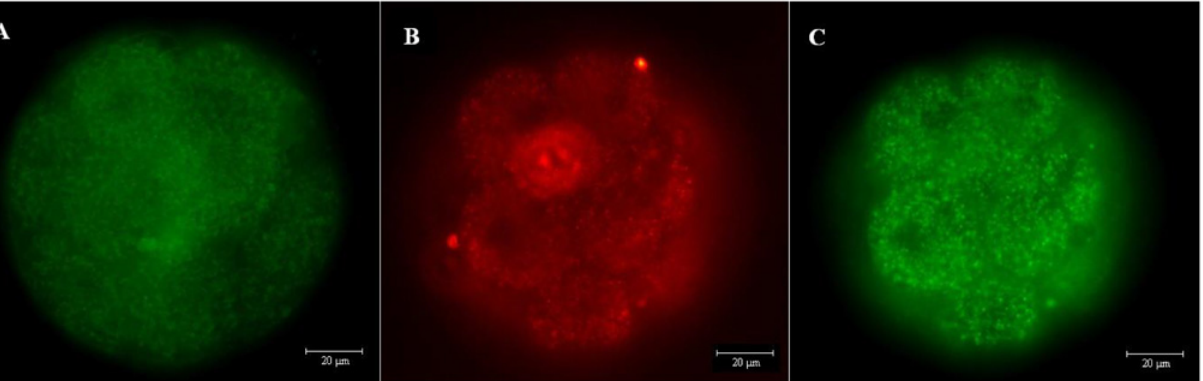
Fig 6. Mitotracker Green and JC-1 staining. Epifluorescence photomicrography of the staining of embryos at 90 hpi: A) blastomeres stained in green = membrane potential detected via staining with Mitotracker Green; B) blastomeres stained in red = membrane potential detected via staining with JC-1; and C) blastomeres stained in green = the absence of membrane potential detected via staining with JC-1.